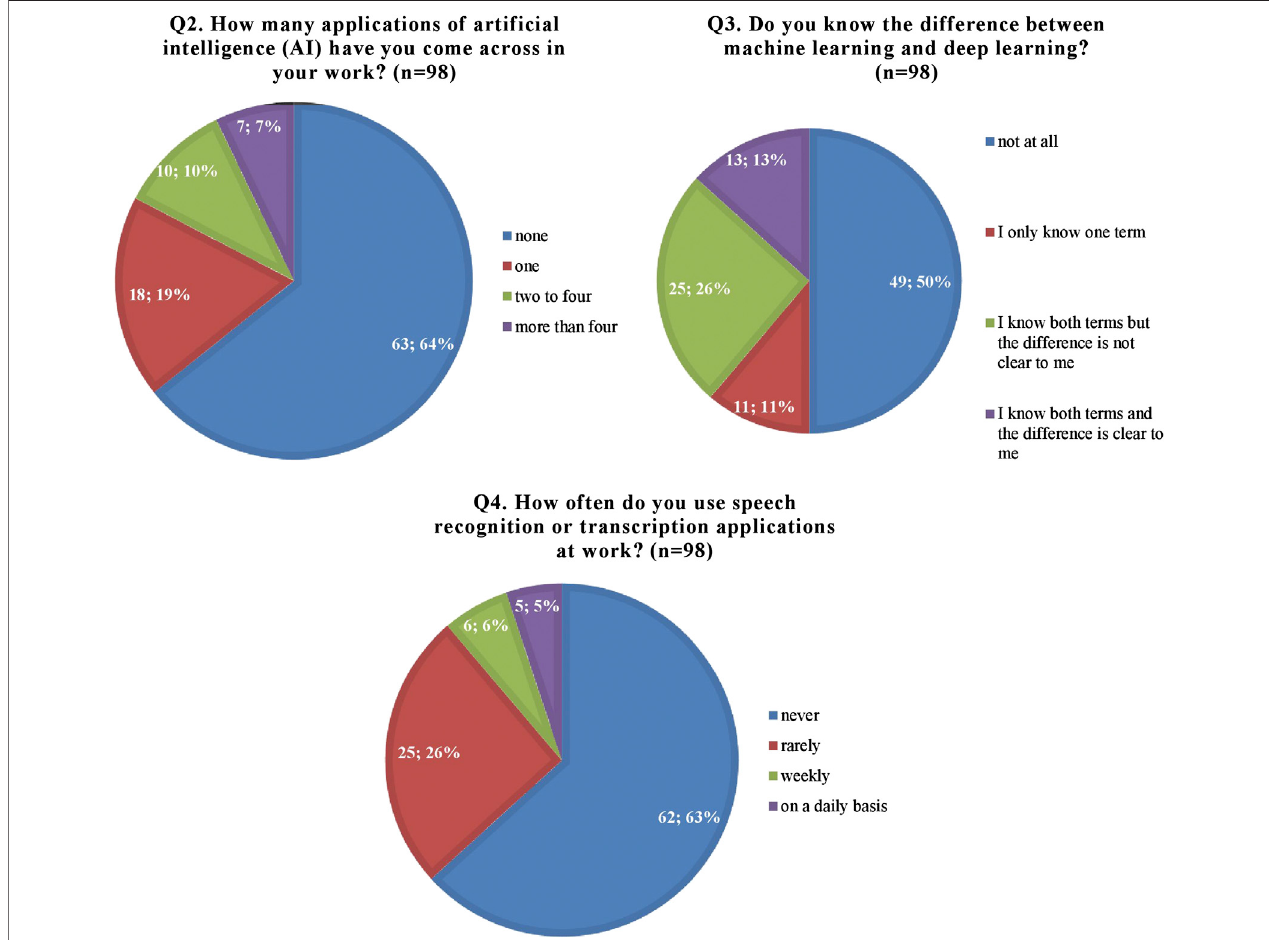
FIGURE 1 | Participants ’ knowledgebase regarding arti fi cial intelligence (AI) and its